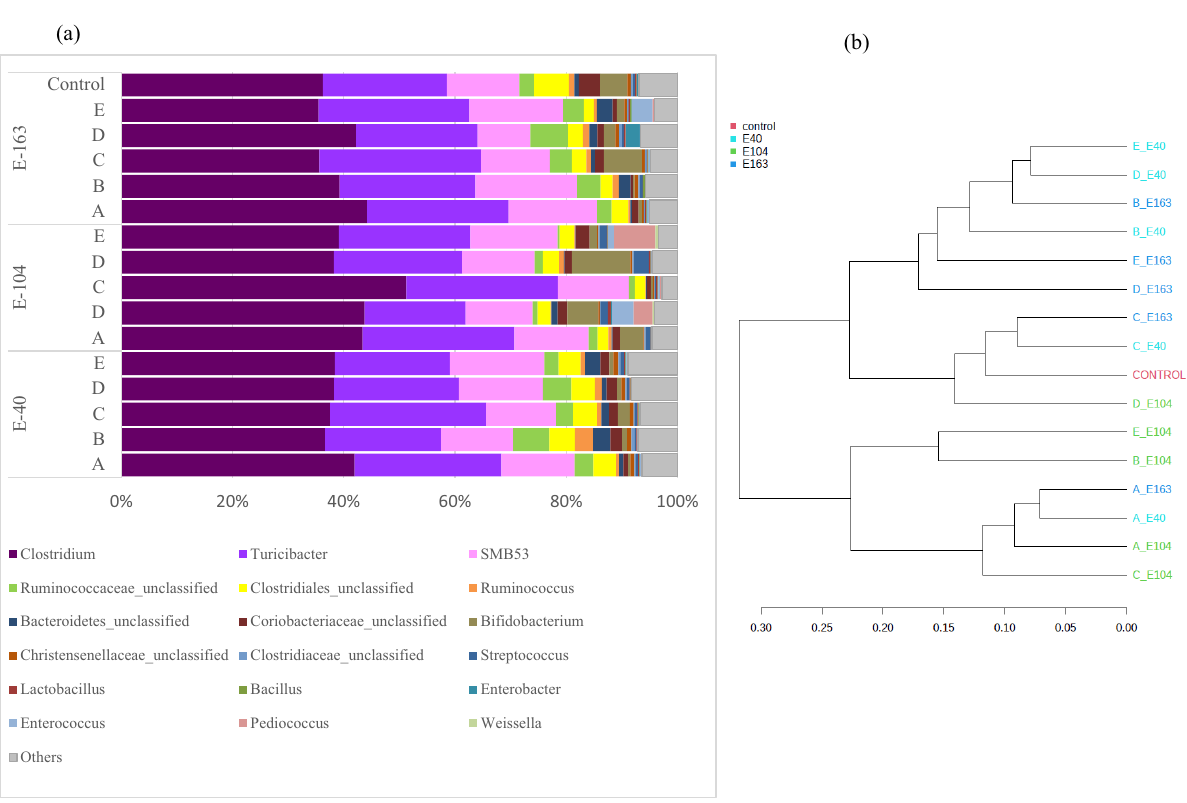
Figure 5. Genus-level distribution ( a ) of the microbiome in probiotic-treated (A: Lactobacillus acidophilus CRL 2074 ; B : Limosilactobacillus fermentum CRL 2085 ; C: Limosilactobacillus mucosae CRL 2069 ; D: CRL 2085 + CRL 2069 ; E: CRL 2074 + CRL 2085 + CRL 2069) and untreated (control) fecal samples of feedlot cattle analyzed at 163 days (T3) after different administration periods. Each color represents a genus. ( b ) Dendrogram representing hierarchical clustering distances based on Bray–Curtis dissimilarity indices calculated at the genus level. For each probiotic group and control sample, T3 was